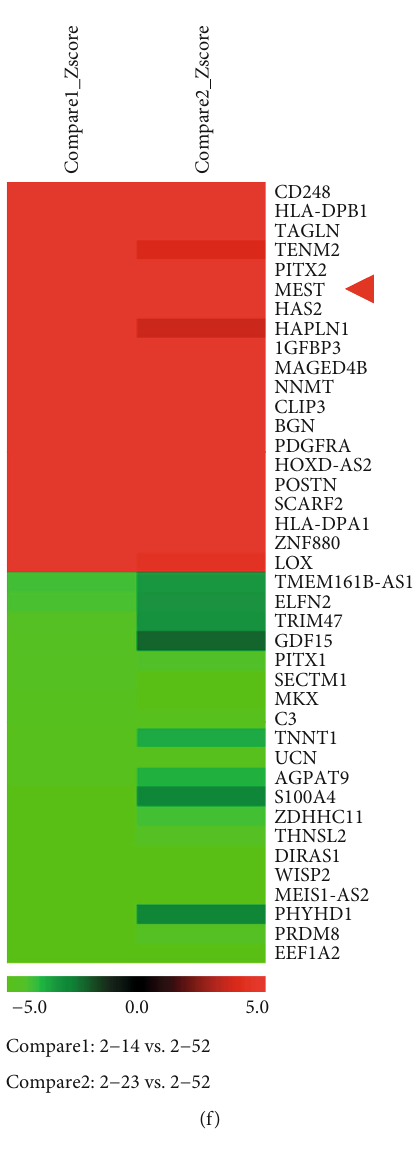
Figure 1: Identi fi cation of MEST by microarray analysis. (a – e) The characterization of 2-14, 2-23, and 2-52 cells. (a) Phase-contrast view of three cell lines ( bars = 40 μ m). (b) The multidi ff erentiation capacity for osteoblasts, adipocytes, and chondrocytes of three cell lines. Alizarin red S staining of cells cultured in osteoblastic di ff erentiation medium for 3 weeks (top row: bars = 5 mm). Oil Red O staining of cells cultured in adipogenic inductive condition for 3 weeks. Inset: higher magni fi ed view of Oil red O-positive lipid (medium row: bars = 20 μ m). Alcian blue staining of cells cultured in chondrogenic inductive condition for 4 weeks (bottom row: bars =200 μ m). (c) The expression intensities of CD105 and CD146 of 2-14 (green line), 2-23 (blue line), and 2-52 (black line) cells was demonstrated by fl ow cytometric analysis. In the gated region, positive cells. (d) The gene expression of p75NTR , N-cadherin , and NANOG in three cell lines was examined by quantitative RT-PCR. It was normalized against β -actin expression. All values are means ± S : D : (error bars) of quadruplicate assays. ∗∗ p < 0 : 01 . (e) The gene expression of Type-1 collagen ( COL-1 ), PLAP-1 , and Periostin ( POSTN ) in three cell lines was examined by semiquantitative RT-PCR. It was normalized against GAPDH expression. (f) Microarray analysis comparing gene expression among three cell lines (left column: 2-14 vs. 2-52 (compare1); right column: 2-23 vs. 2-52 (compare2)). Heatmap was generated by MeV software. Rows represent the genes, and columns represent the samples. Colors indicate the distance from the median of each row (red blocks: high; green blocks: low; black blocks: similar